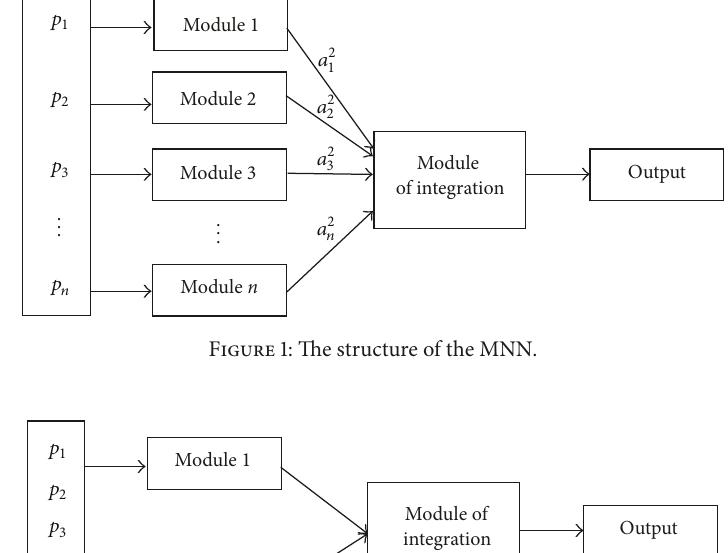
Figure 2: The structure of the MNN with 2